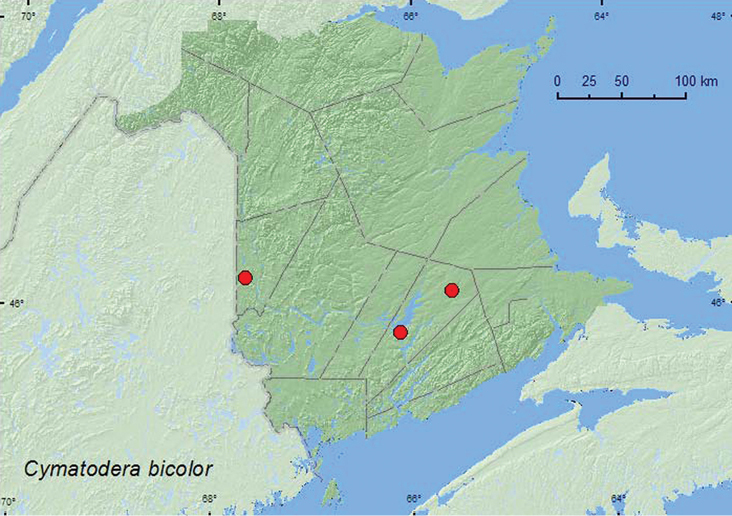
Collection localities in New Brunswick, Canada of Cymatodera bicolor.